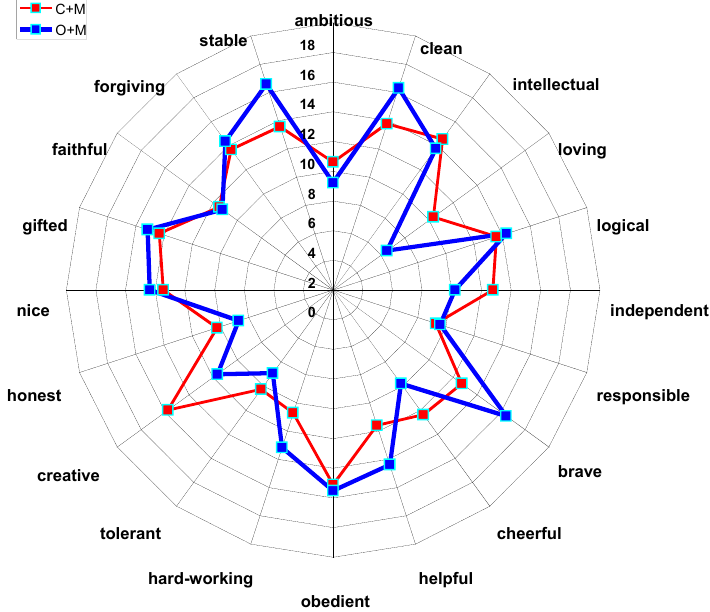
Figure 4. List of instrumental value preferences of Catholic and Orthodox respondents from mixed Catholic-Orthodox families. Source: own study based on research results.